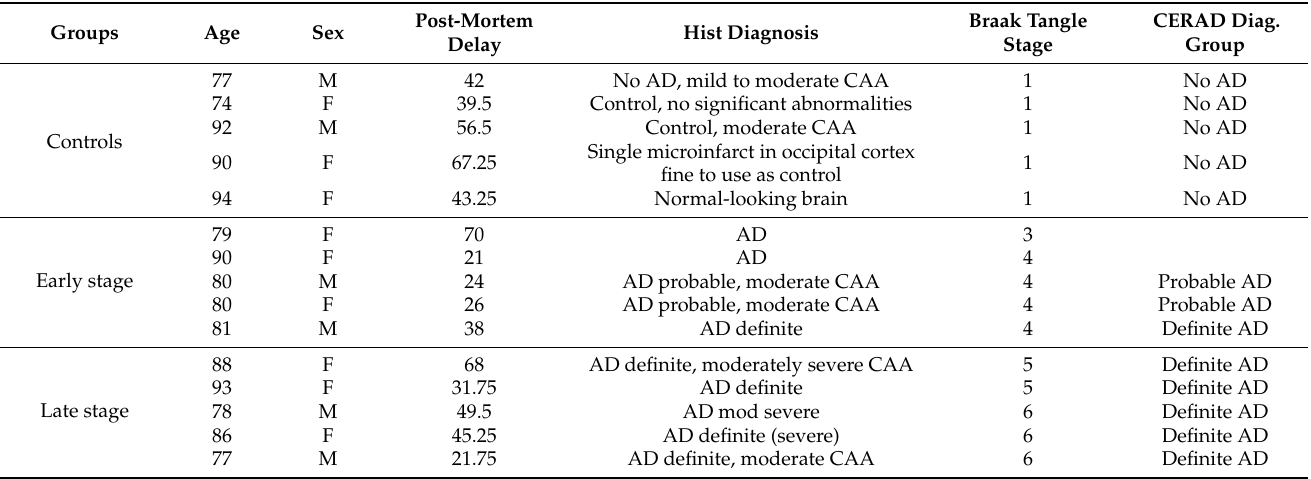
Table 1. Demographics of samples received from South-West Dementia Brain Bank. CAA= cerebral amyloid angiopathy.